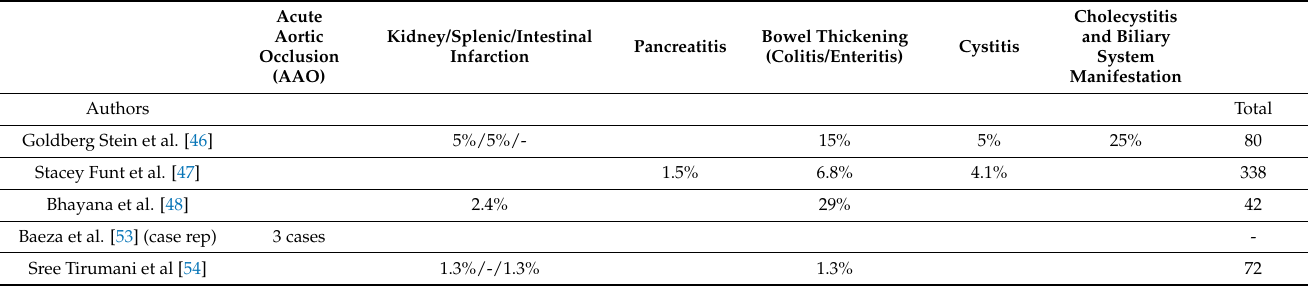
Figure 15. ( A ) Cholecystitis and ( B ) cystitis. Table 3 summarizes all the studies reported in the Section 4: Adult “Abdominal” COVID-19. Table 3. Adults “Abdominal” COVID-19.